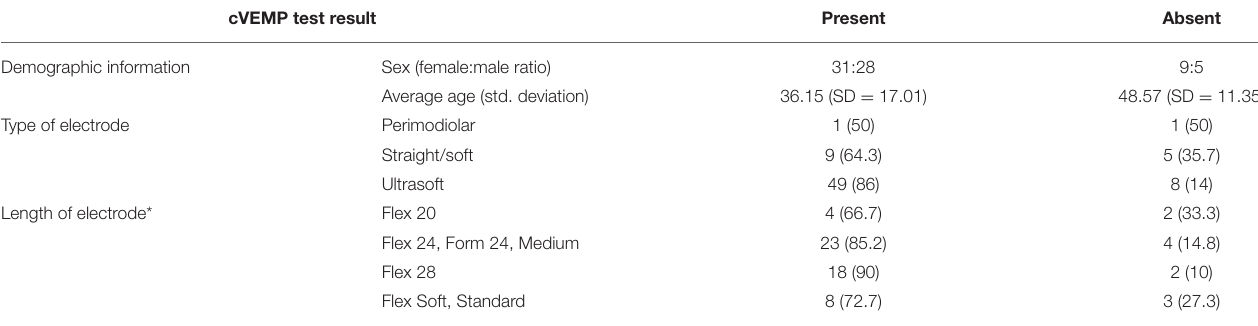
TABLE 1 | Postoperative cVEMP